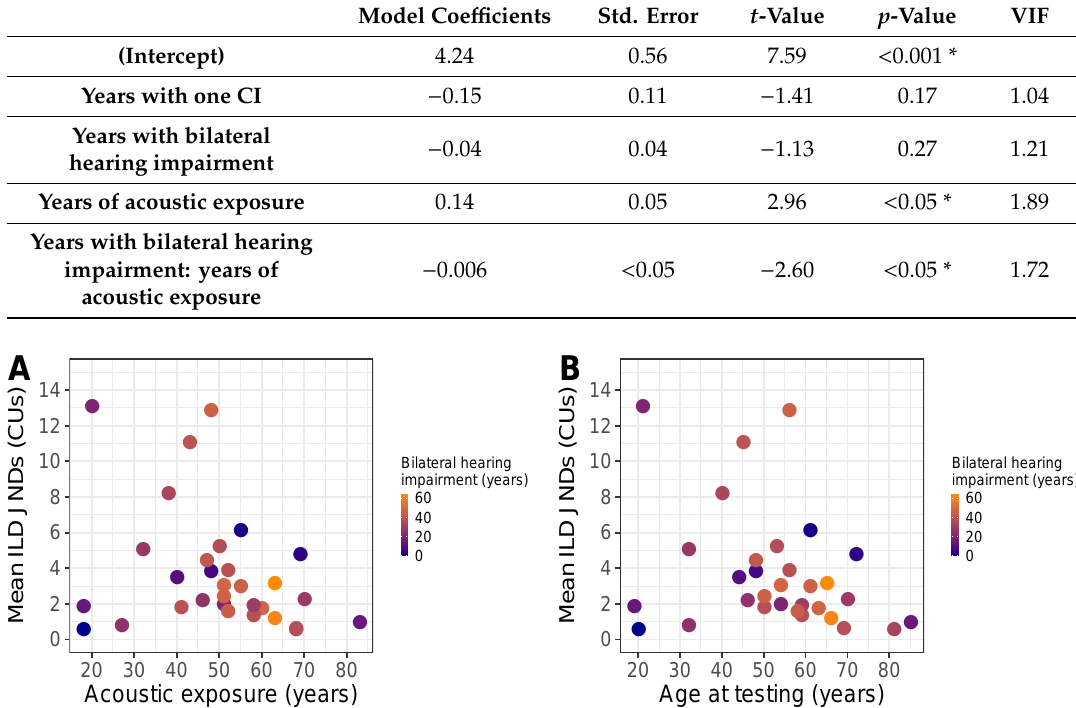
Table 3. Model coe ffi cients and p -values for ILD JND model. Asterisks denote significant predictors. Model Coe ffi cients Std. Error